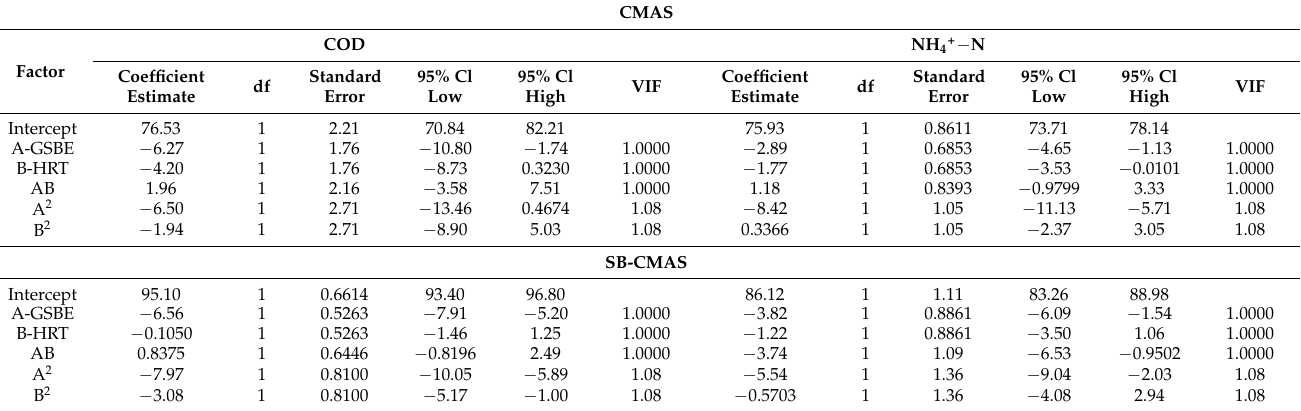
Table 7. Coefficients in terms of coded factors for the